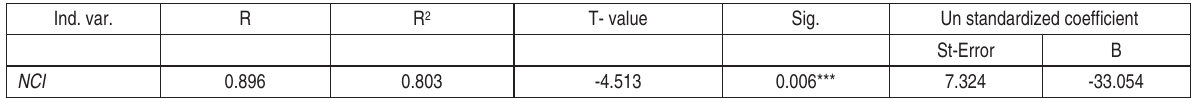
Table 3. Regression analysis of structural indicators for the European Union banking